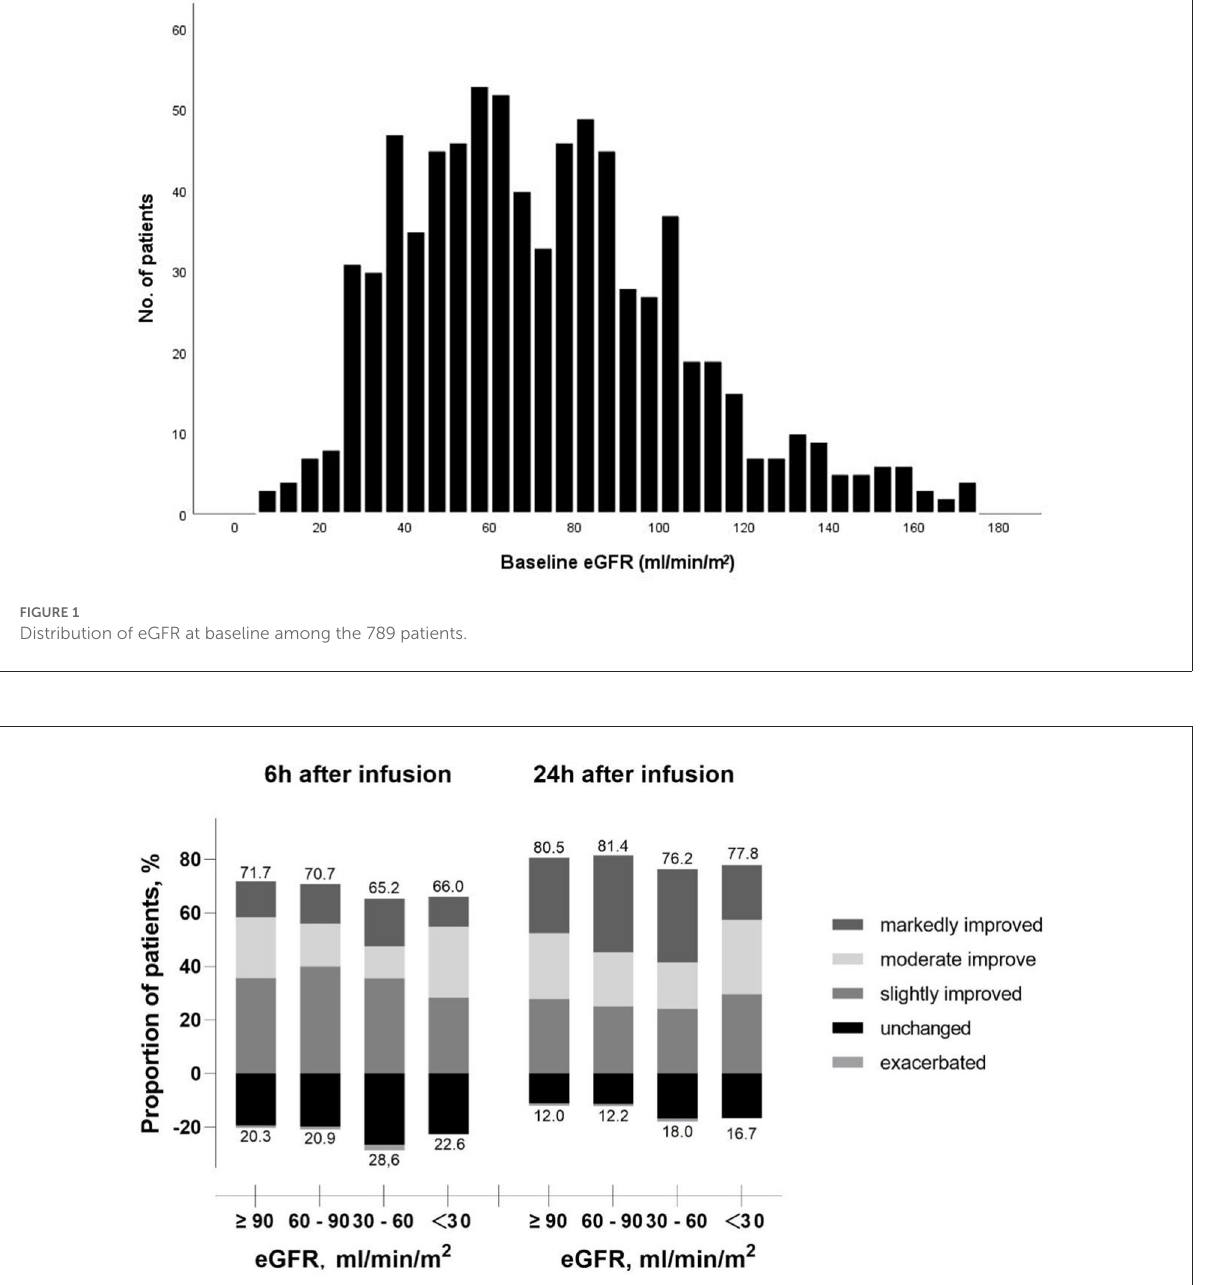
and pruritus occurred in 9 patients (1.1%). In those with eGFR lower than 30 ml/min/m2, 5 patients suffered from adverse events, including hypotension (1 case) and new onset arrhythmia (4 cases),